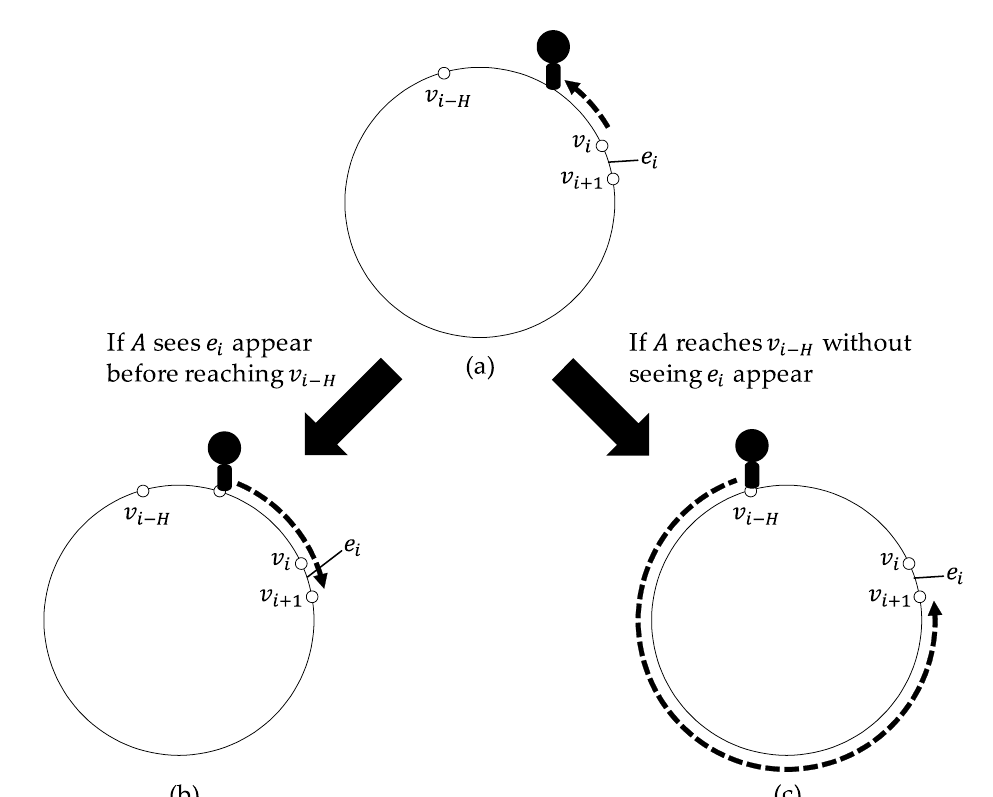
Figure 3. The moves of A by E XP O NE ( t , v i ) in the case where v i is the right extremity. ( a ) Unless A sees e i appear, A moves to left. ( b ) If A sees e i appear before reaching v i − H , A starts to move to right and reaches v i + 1 . ( c ) If A reaches v i − H without seeing e i appear, A keeps moving to left until reaching v i + 1 and finishes the